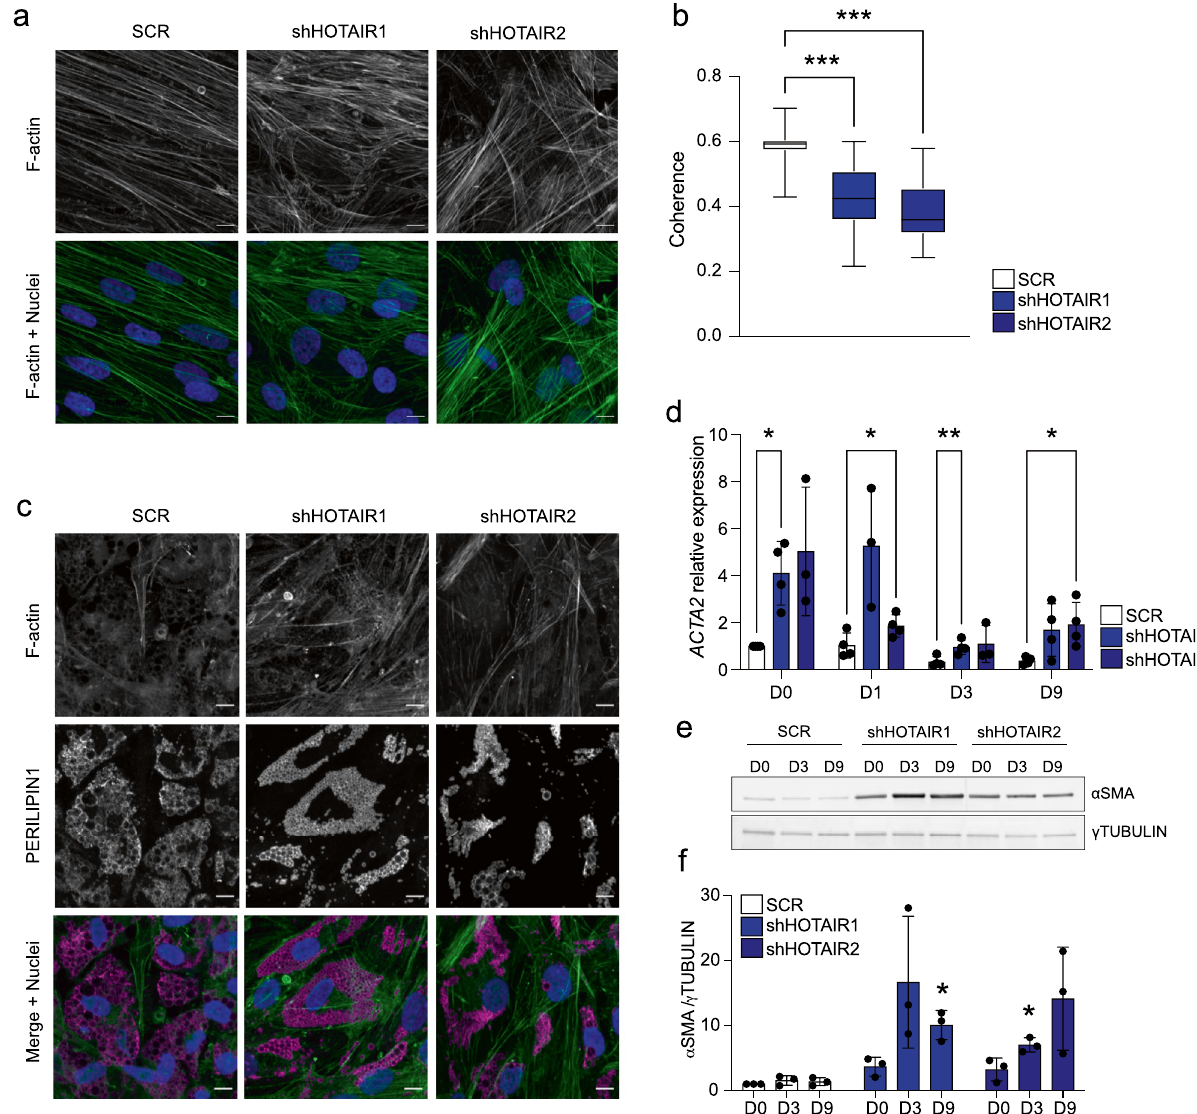
Figure 3. HOTAIR KD prevents cytoskeletal remodeling during adipogenesis.( a ) Phalloidin staining of F-actin in D0 SCR and sh HOTAIR G-ASCs. Nuclei are stained with Hoechst. Scale bar: 10 µm. ( b ) Quantification of coherence in F-actin fibers alignment in D0 SCR and sh HOTAIR G-ASCs (*** p < 0.0001, two-way ANOVA with Dunnett’s multiple comparisons test; n = 3 experiments, with ≥ 4 fields measured per experiment, 5 measurements per field). ( c ) Phalloidin staining of F-actin (green) and immunostaining of PERILIPIN1 (magenta) in differentiated (D9) SCR and sh HOTAIR G-ASCs. Nuclei are stained with Hoechst. Scale bar: 10 µm. ( d ) Relative expression of ACTA2 in differentiating scrambled control (SCR) and sh HOTAIR G-ASCs , normalized to SCR D0 (mean fold difference ± SD; * p < 0.05, ** p < 0.005, two-way ANOVA with Dunnett’s multiple comparisons test; n ≥ 3). ( e ) Western blot analysis (see Fig. S7for original blots) and ( f ) quantification of αSMA protein levels in differentiating SCR and sh HOTAIR G-ASCs (mean fold difference ± SD; *p < 0.05, two- way ANOVA with Tukey’s multiple comparisons test; n = 3). γ-Tubulin is shown as a loading